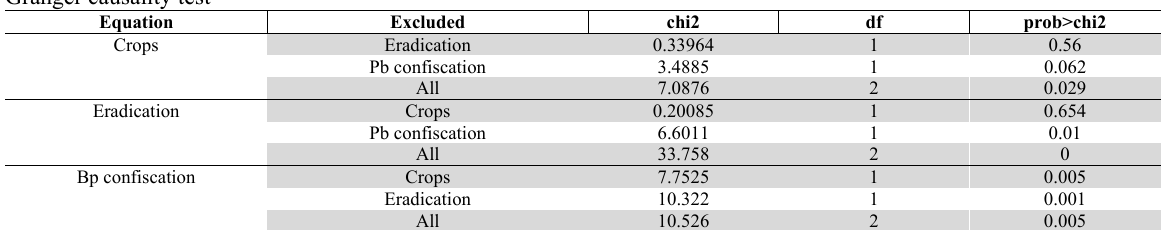
Granger causality test Equation